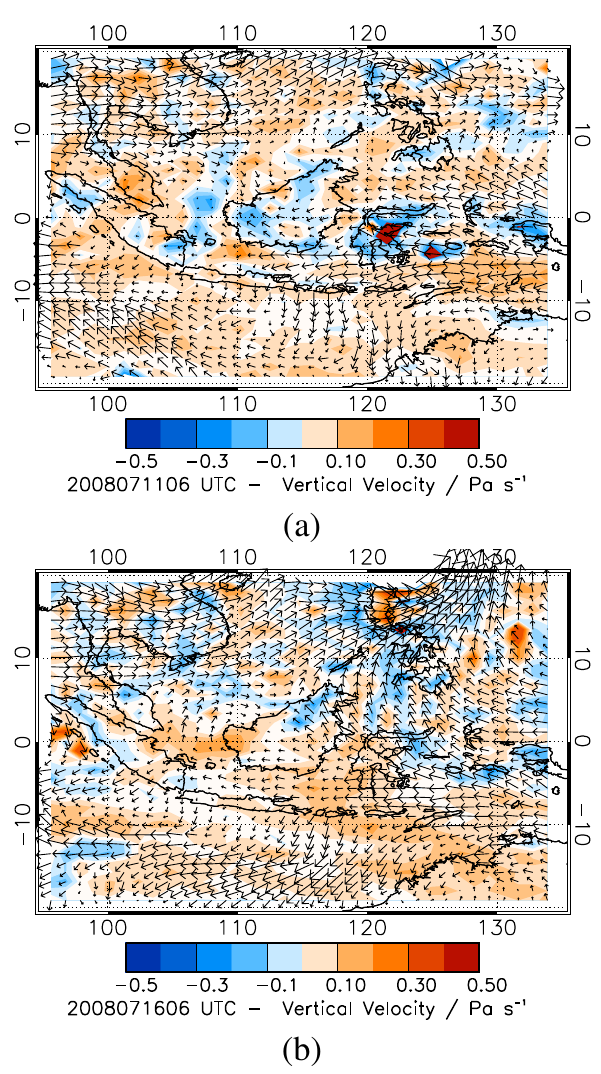
Fig. 3. Horizontal winds (scaled arrows) and vertical winds (coloured contours as per legend) in the Tropical Western Pacific region from ECMWF reanalyses, interpolated to the 850 hPa isobar for (a) 11 July 2008 and (b) 16 July 2008, both at 02:00 p.m. LT.